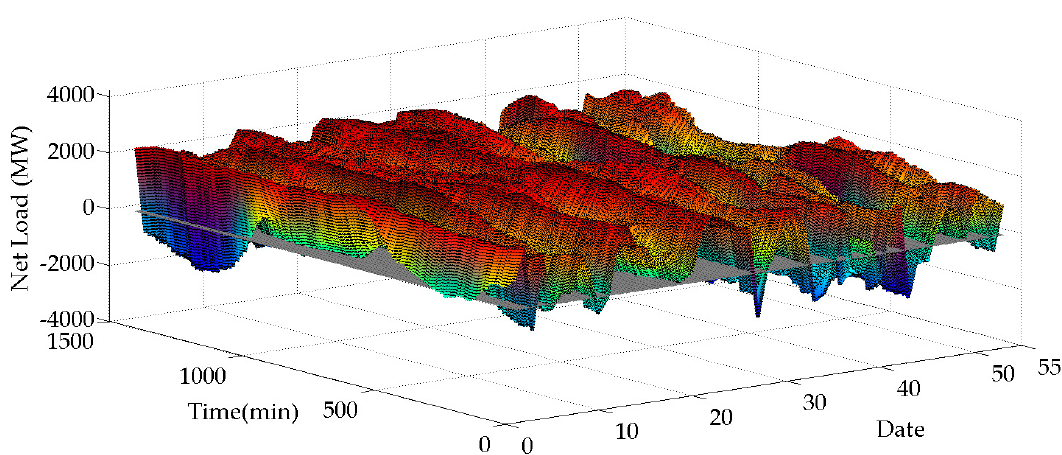
Figure 3. Net load curve of one province from 3 March to 24 April.